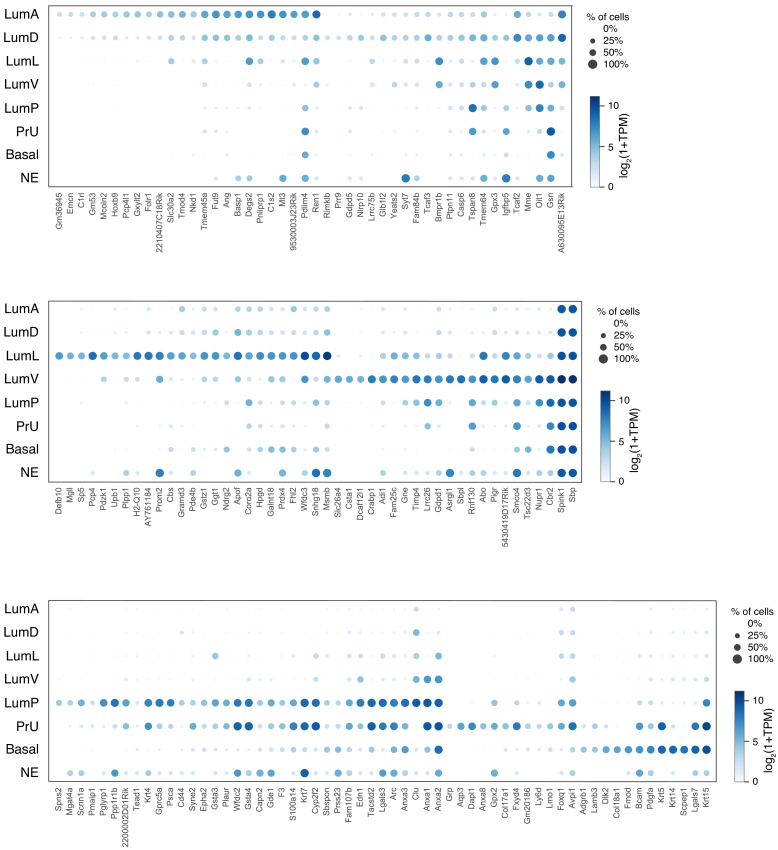
Dot plot of expression levels for selected genes in each epithelial population.An expanded list of genes is shown to complement the dot plot in Figure 1D.